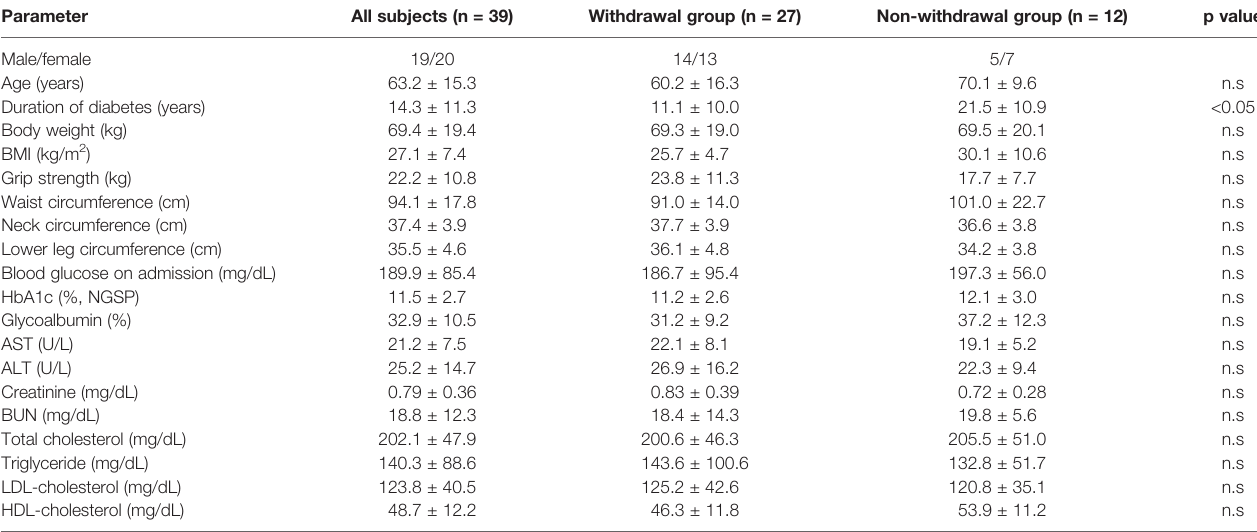
TABLE 5 | Clinical characteristics of patients with D CPR of 1.0 ng/mL or higher.